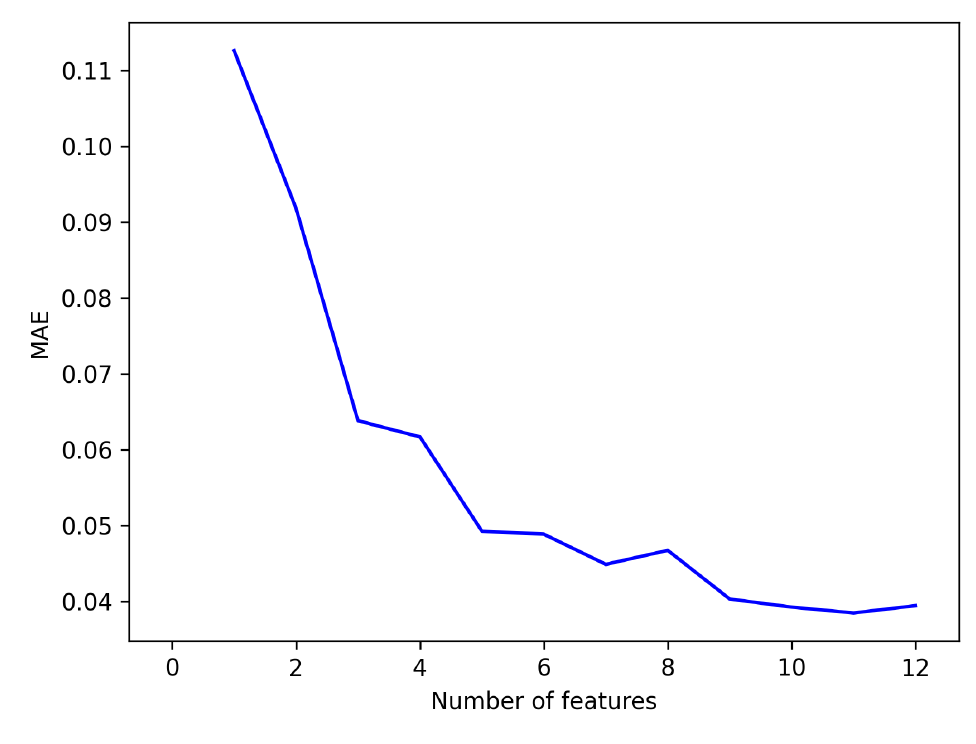
Figure 10. MAE vs. number of